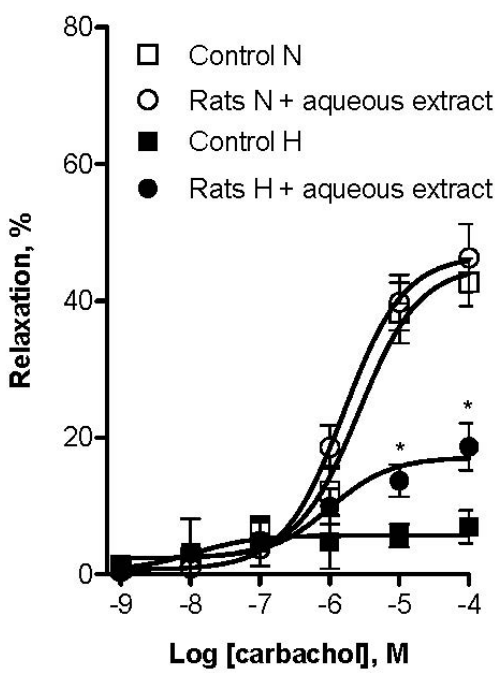
Figure 6. Effect of long-term oral administration of aqueous extract of black cherry fruits (300 mg/Kg/day) on vascular reactivity after four weeks treatment. Concentration-response curves are presented as percentage of relaxation of rat aortic rings pre-contracted by L-phenylephrine (1 µM) as a function of carbachol (CCh) concentration. L-NAME hypertensive induced rats group that received black cherry extract showed better response to CCh than L-NAME hypertensive induced rats group that not received black cherry extract. Normotensive rats groups had no significant difference from each other in their vascular reactivity. Each individual value is a mean ± SEM ( n = 6). * p ˂ 0.05 vs .